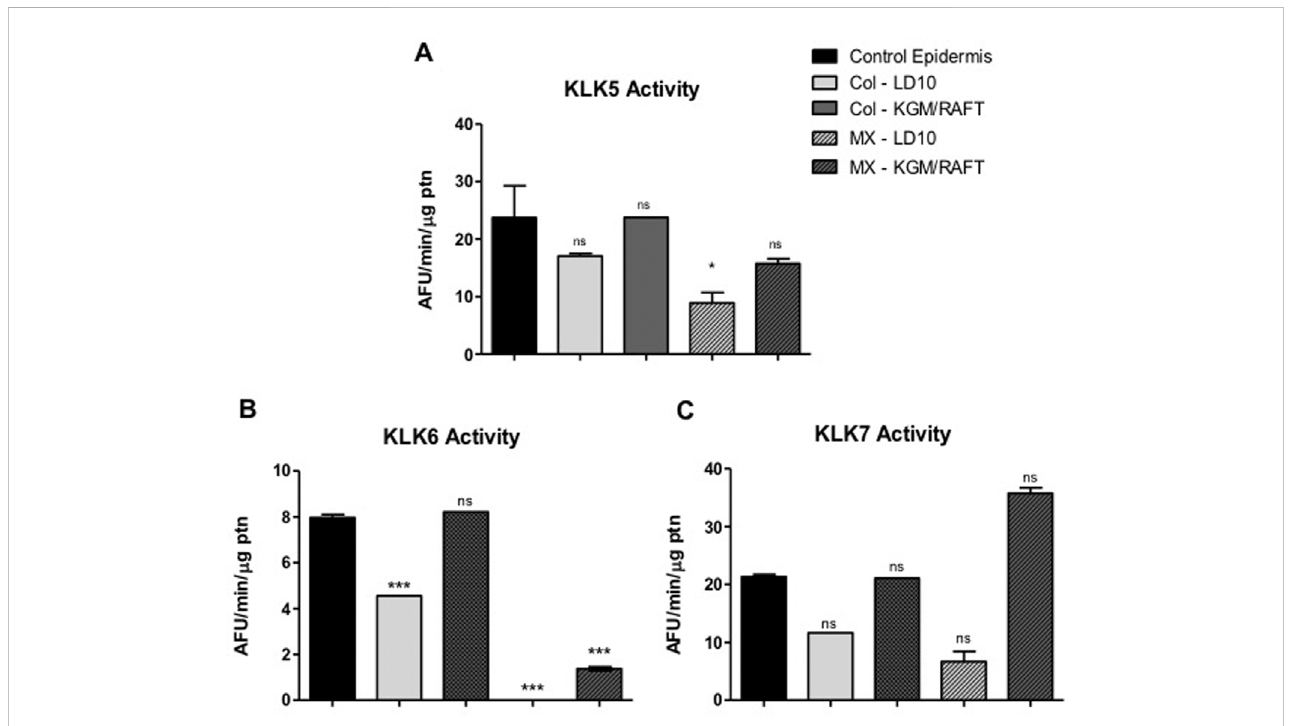
FIGURE 9 KLK activity in MSC induced to epidermal differentiation onto dermal equivalents. MSCs were cultured for 1 day in the different differentiation media or LD10 and exposed to ALI for 10 days. The enzymatic activity of (A) KLK5, (B) KLK6 and (C) KLK7 in cell extracts was determined on the hydrolysis of their respective substrates, in keratinocytes or MSCs cultured onto the dermal equivalent of collagen with fi broblasts or MatriXpec ™ . Control epidermis formed by basal keratinocytes. ns: not signi fi cant. * ( p < .05) or *** ( p < .001), different compared to control epidermis. KLK: tissue kallikrein. AFU/min/ μ g ptn: arbitrary fl uorescence unit/minute/ μ g of protein in the epidermis